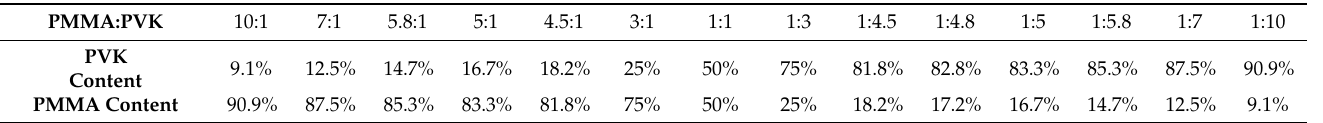
Table 1. A list of investigated samples with information about PMMA to PVK volumetric ratios, PVK, and PMMA content.